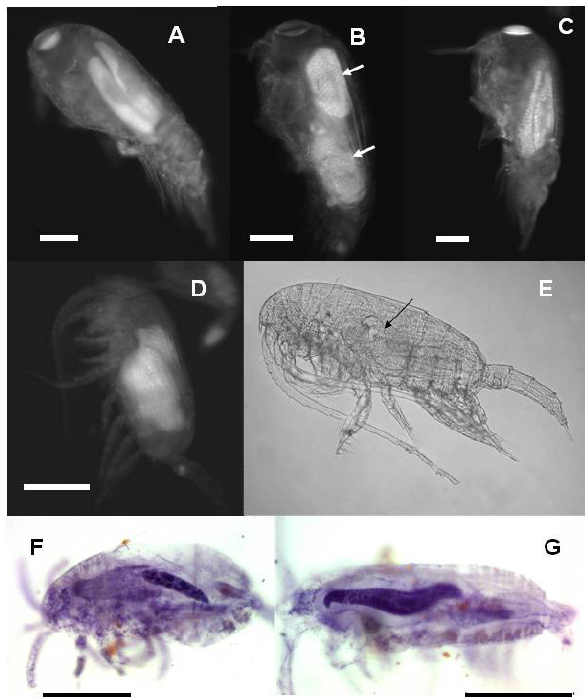
Fig. 2. Observations of Blastodinium spp. located inside the gut of their hosts. (A) Three individuals of Blastodinium mangini infect- ing Farranula cf. rostrata (BOUM19). (B) At least two individuals (arrows) of an unknown Blastodinium with a globular shape infect- ing Farranula cf. rostrata (BOUMD9). (C) Unknown Blastodinium infecting Farranula cf. rostrata (BOUM18). (D) Two individuals of an unknown Blastodinium with a globular shape infecting Clauso- calanus furcatus (BOUM17). (E) Blastodinium contortum infect- ing Clausocalanus furcatus (BOUMB). (F) Blastodinium cf. spin- ulosum infecting a probable Clausocalanus sp. (G) Hypertwisted Blastodinium contortum infecting a probable Haloptilus sp. Indi- viduals from (A) to (D) were observed after DNA-staining by Pro- pidium Iodide. Individuals from (F) and (G) were stained using Gill’s Hematoxylin. Scale bars=100µm.